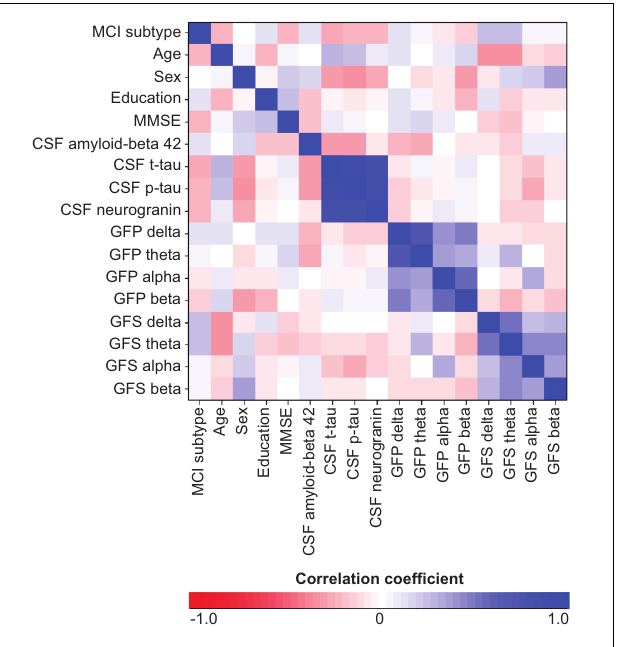
FIGURE 2 | Correlation matrix between all predictors and outcome variable of the random forest model. MCI subtype was coded as sd-aMCI = 0 and md-aMCI = 1. Sex was coded as women = 0 and men = 1. GFP, global field power; GFS, global field synchronization; MMSE, Mini-Mental State Examination; CSF, cerebrospinal